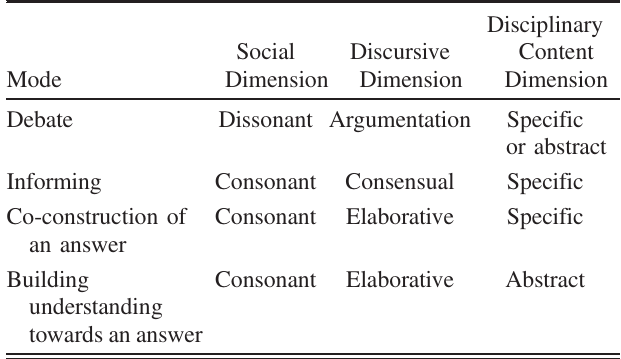
TABLE I. Summary of the three dimensions. TABLE II. Summary of the modes of collaboration identified in our